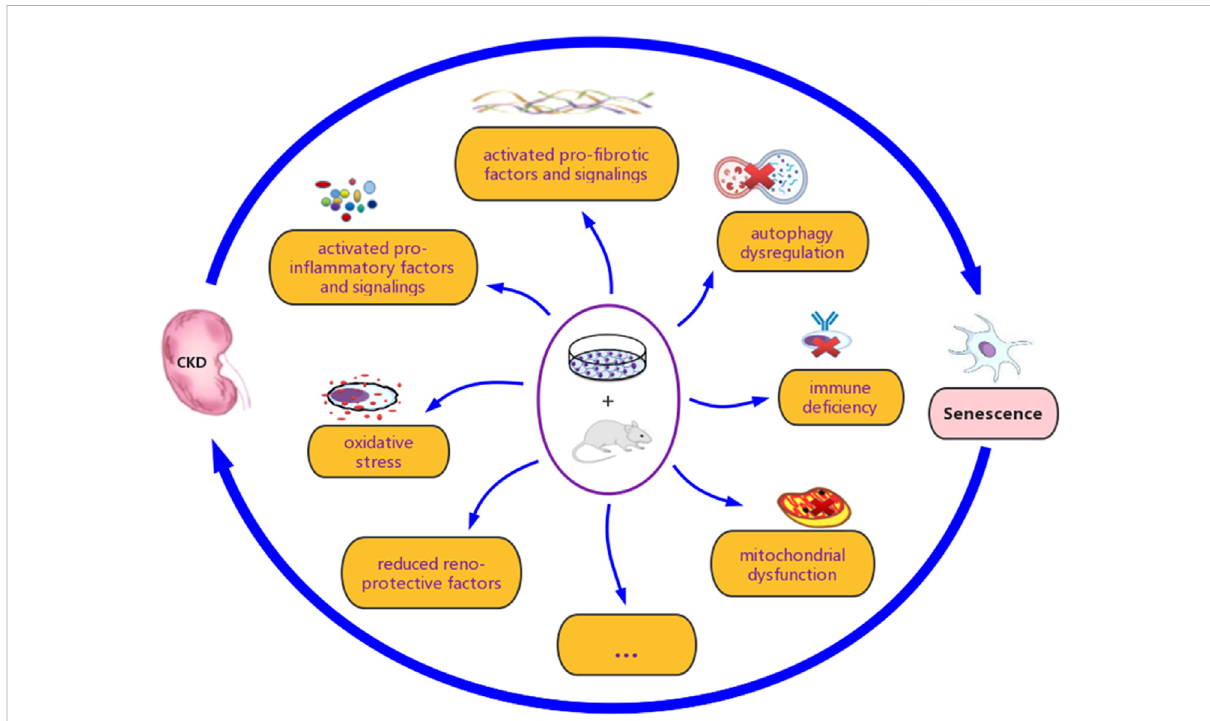
FIGURE 4 The interactive association between renal senescence and chronic kidney disease (CKD). Various studies have demonstrated that renal senescence and CKD are closely related, both in vitro and in vivo . Oxidative stress, mitochondrial dysfunction, loss of reno-protective factors, secretion of pro-in fl ammatory and pro- fi brotic factors, activation of associated signaling pathways, autophagy inhibition, and immune de fi ciency, are considered to be involved in their complex